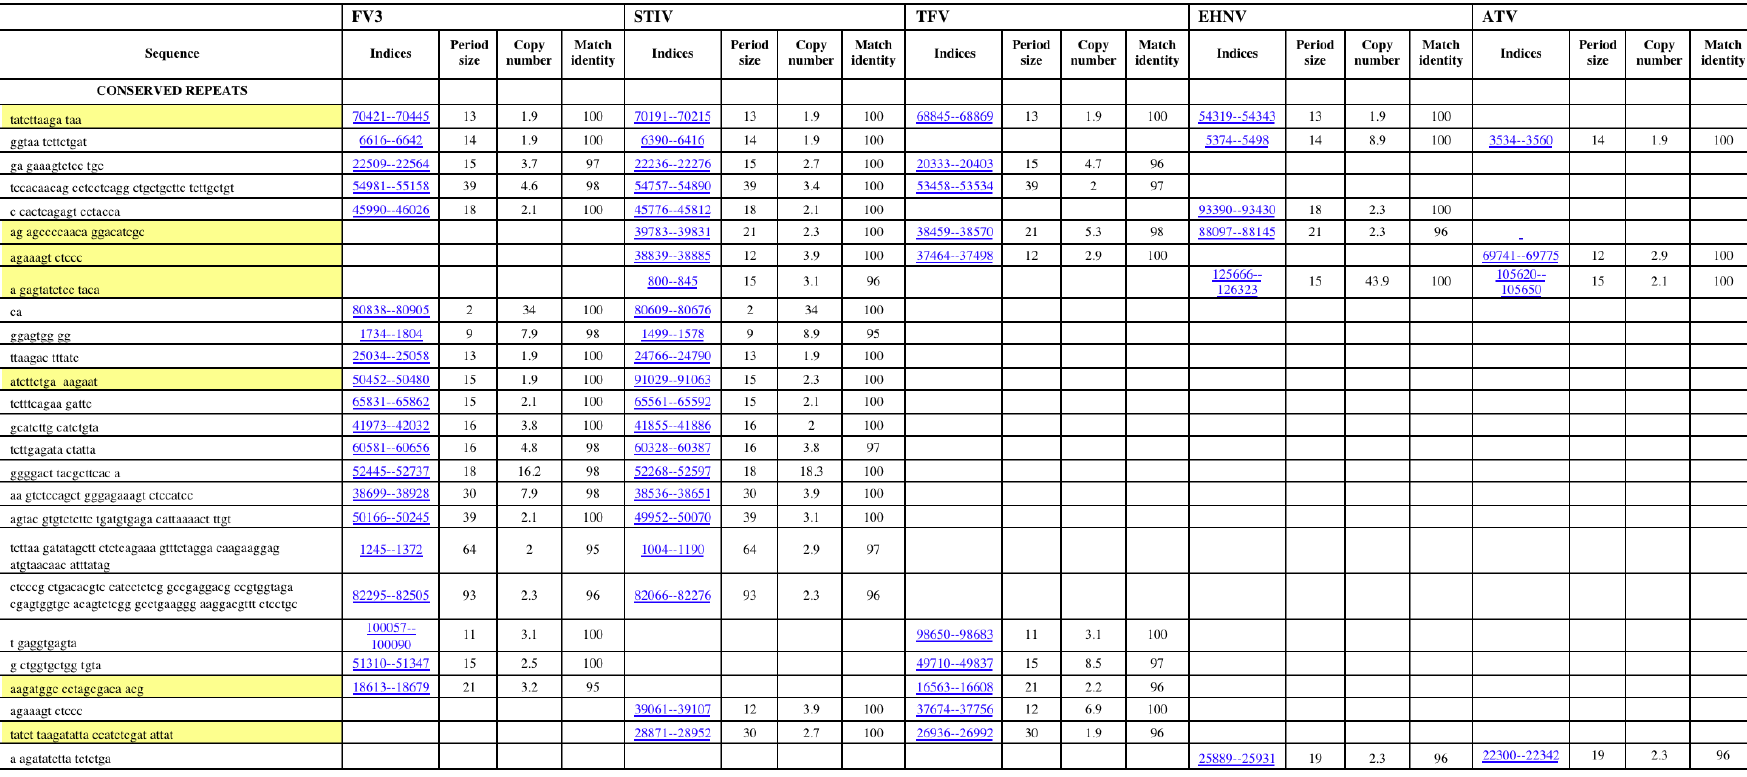
Table 1. Conserved repeats found in FV3, STIV, TFV, EHNV, and ATV. Repetitive sequences highlighted in yellow represent a repeat that differs in one nucleotide between